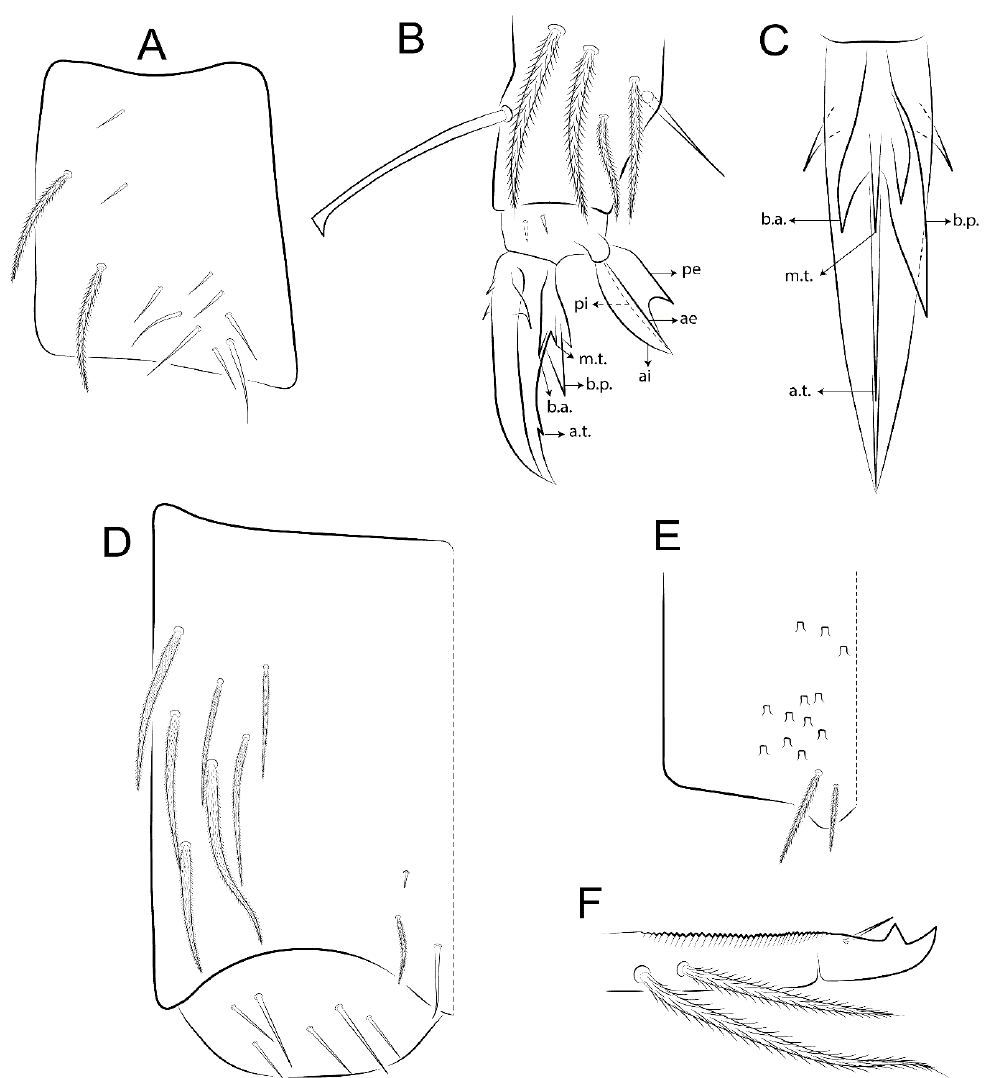
Figure 36. Pseudosinella unimacrochaetosa sp. nov.: trunk appendages. ( A ) trochanteral organ; ( B ) distal tibiotarsus and empodial complex III (anterior view); ( C ) unguis (inner view); ( D ) collophore (lateral view); ( E ) distal part of manubrium (ventral view); F ) distal dens and mucro (outer view).